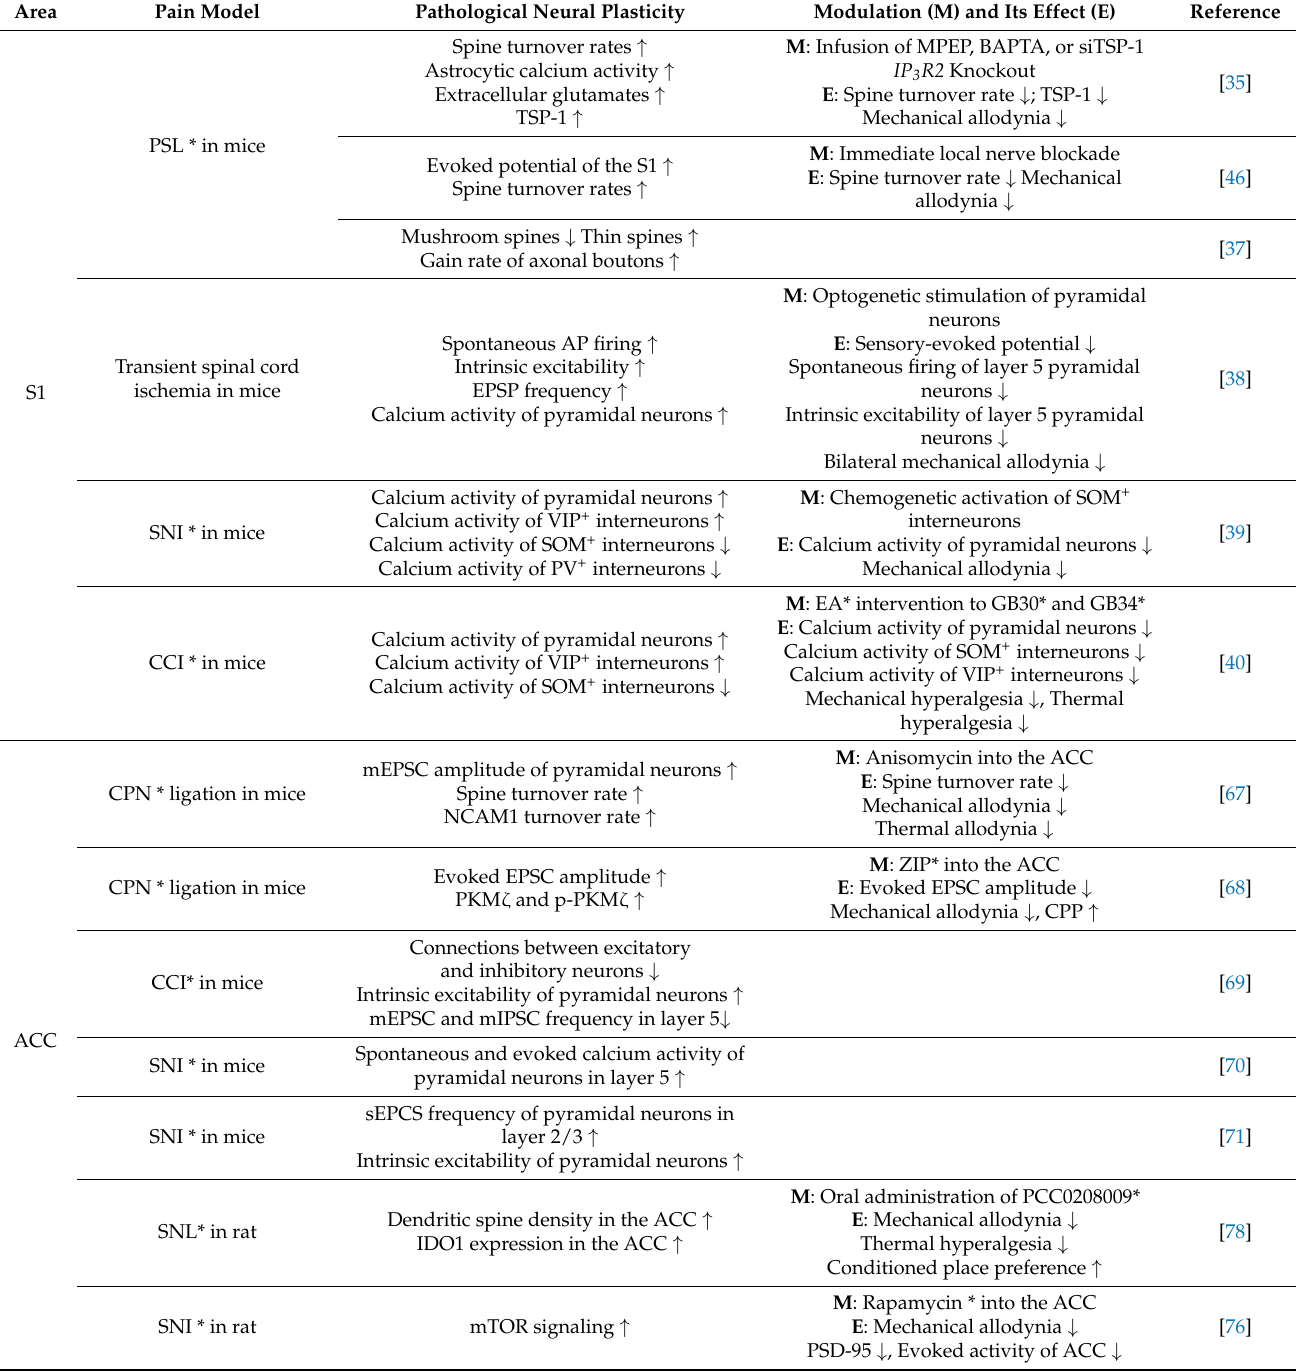
Table 1. Neural plasticity in the brain during neuropathic pain and its